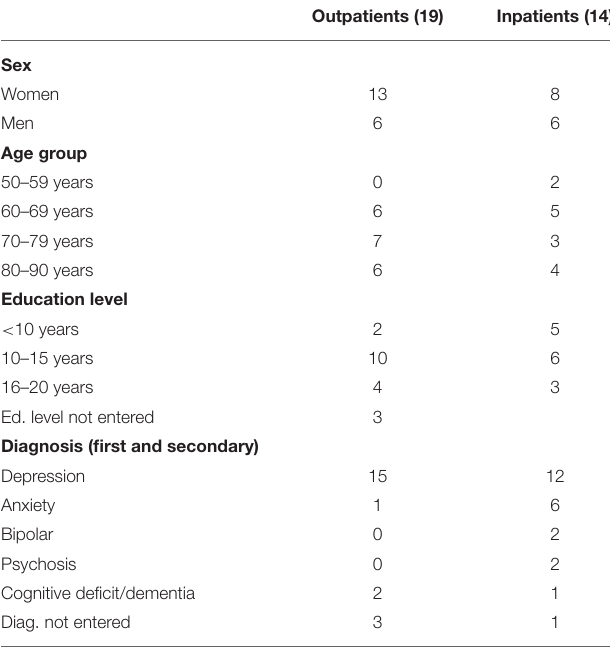
TABLE 3 | Demographic characteristics, and